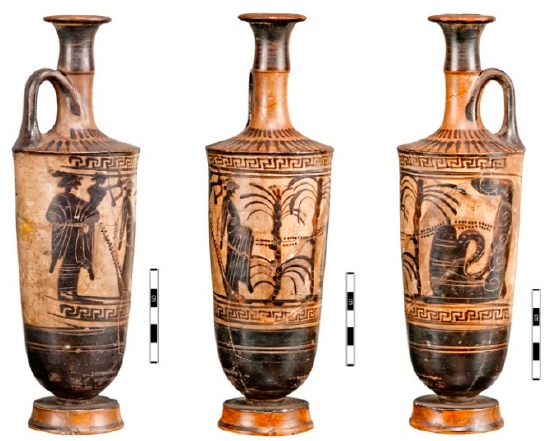
Figure 1. Baby Apollo, Leto, Artemis and Python. (CdM inv. no. 306; black-figure lekythos; attr. to the Pholos Group; Athens; ca. 500 BCE .) [© Cabinet des M é dailles et Antiques de la Biblioth è